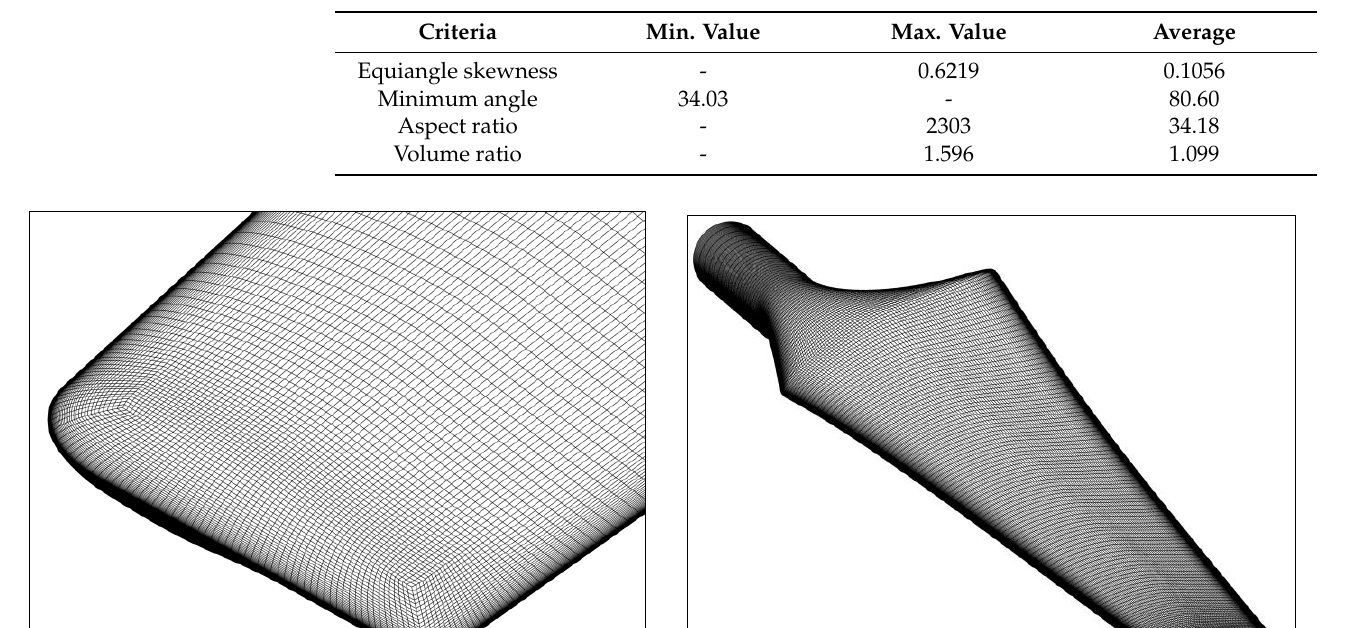
Table 2. Mesh quality statistics.